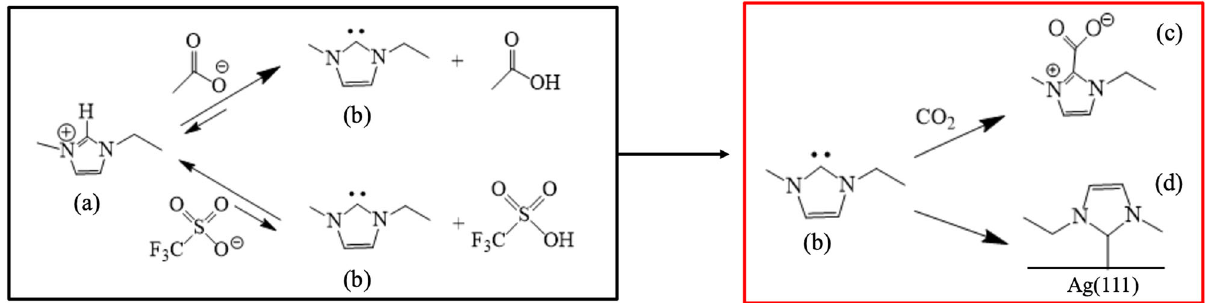
Fig. 2 Chemical equilibrium of imidazolium in the presence of different anions: a non- fl uorinated ([CO 2 CH 3 ] − ) and a fl uorinated one ([SO 3 CF 3 ] − ). Since this reaction mechanism foresees only the involvement of the imidazolium ring, and the alkyl chain does not play a key role, it is assumed that the same reactions occur for the [BMIM] + cation. a Represents the cation, [EMIM] + ; ( b ) is the carbene, EMIM:, ( c ) is the carboxylated cation, and ( d ) is the cation chemisorbed in the Ag surface, [EMIM]*.